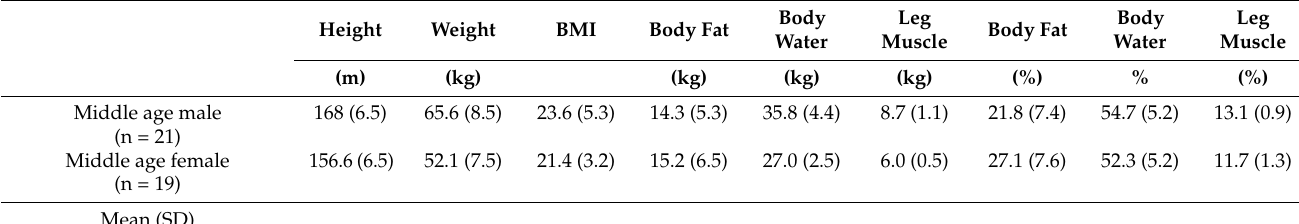
Table 1. Demographic data of middle aged male and female